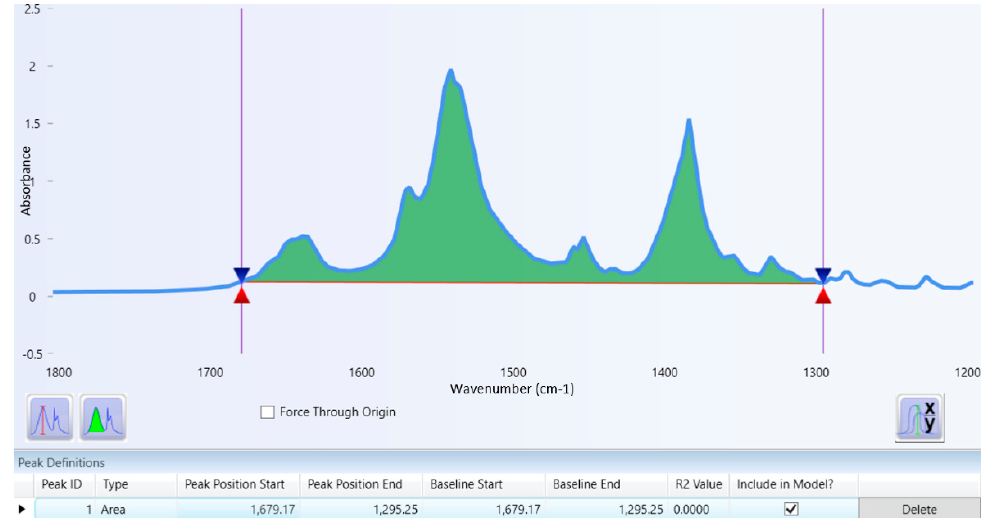
Figure 3. Baseline and area for quantitative analysis of tranexamic acid.